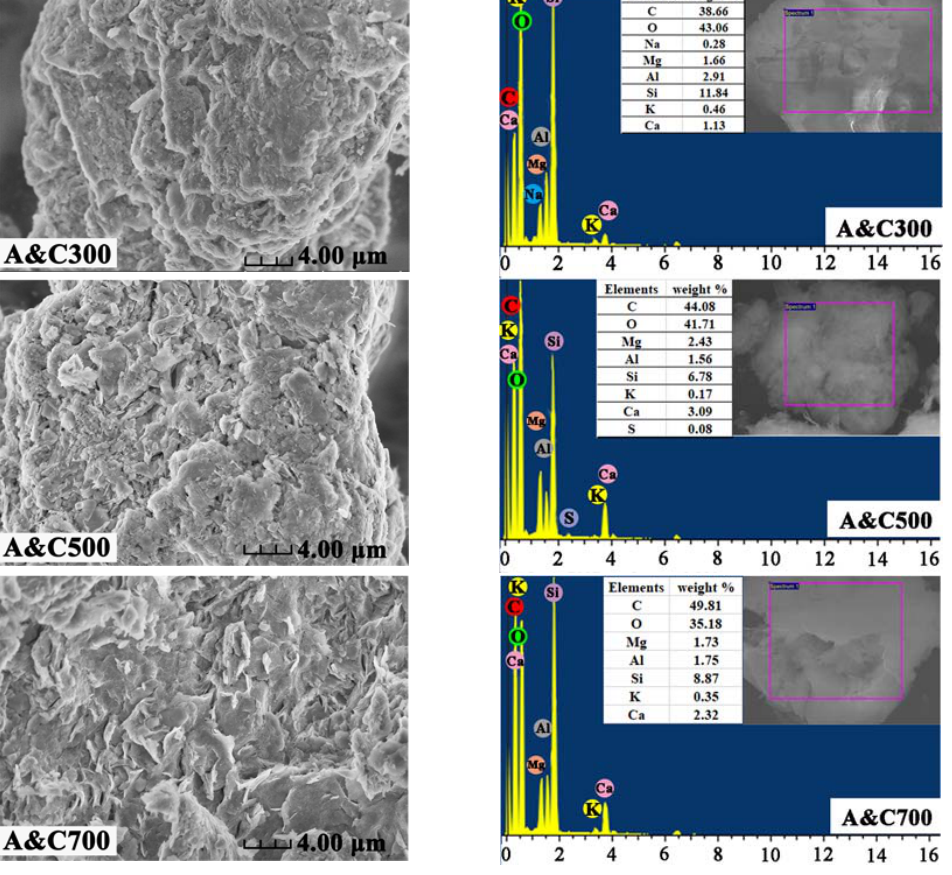
Figure 1. SEM ‐ EDS images for A&C300, A&C500 and A&C700. Figure 1. SEM-EDS images for A&C300, A&C500 and